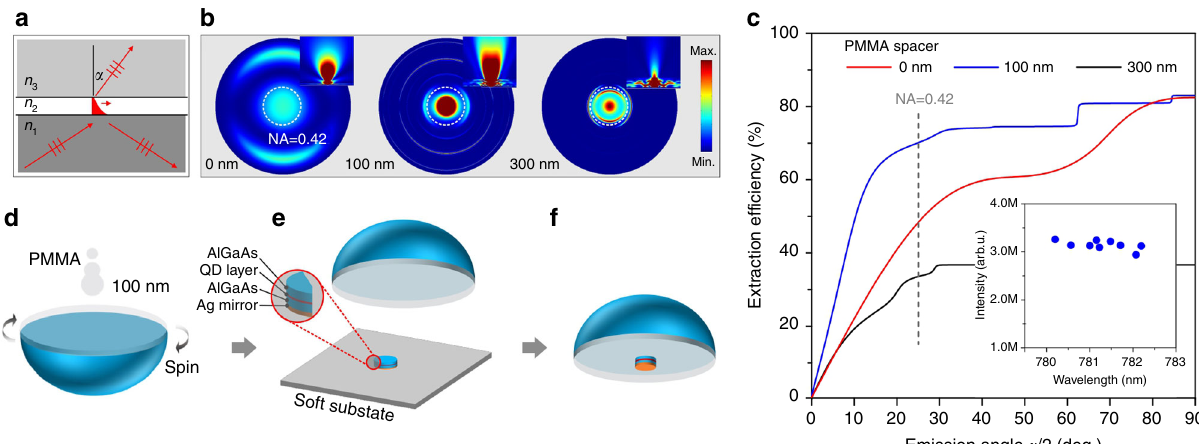
Fig. 1 Dielectric antenna design and numerical results. a Illustration of light propagating at the media interfaces. The three media ful fi ll n 1 (cid:3) n 3 > n 2 as in our design. The evanescent wave caused by total internal re fl ection at the interface will be coupled to the propagating wave when the intermediate gap decreases. b Far fi eld view and cross section (inset) of dielectric antennas ’ emission. PMMA spacers with different thicknesses, thus different coupling strength, are considered. The collection angle of a NA = 0.42 lens is indicated by the dashed circle. Antenna with 100 nm PMMA spacer gives the best result in terms of coupling strength and emission angle. c – e Fabrication fl ow of the device. The dielectric antenna consists of an AlGaAs membrane (with embedded QDs), a low refractive index PMMA spacer and the GaP solid immersion lens (SIL), with the refractive indices of n 1 , n 2 , and n 3 , respectively. A bottom silver mirror is used to re fl ect downward-emitted photons. f Numerical results for the dielectric antenna as a function of emission angle α . The collection angle of a NA = 0.42 lens is indicated by the dashed line. Inset shows the broadband operation of the dielectric antenna. All QDs randomly chosen across the membrane are